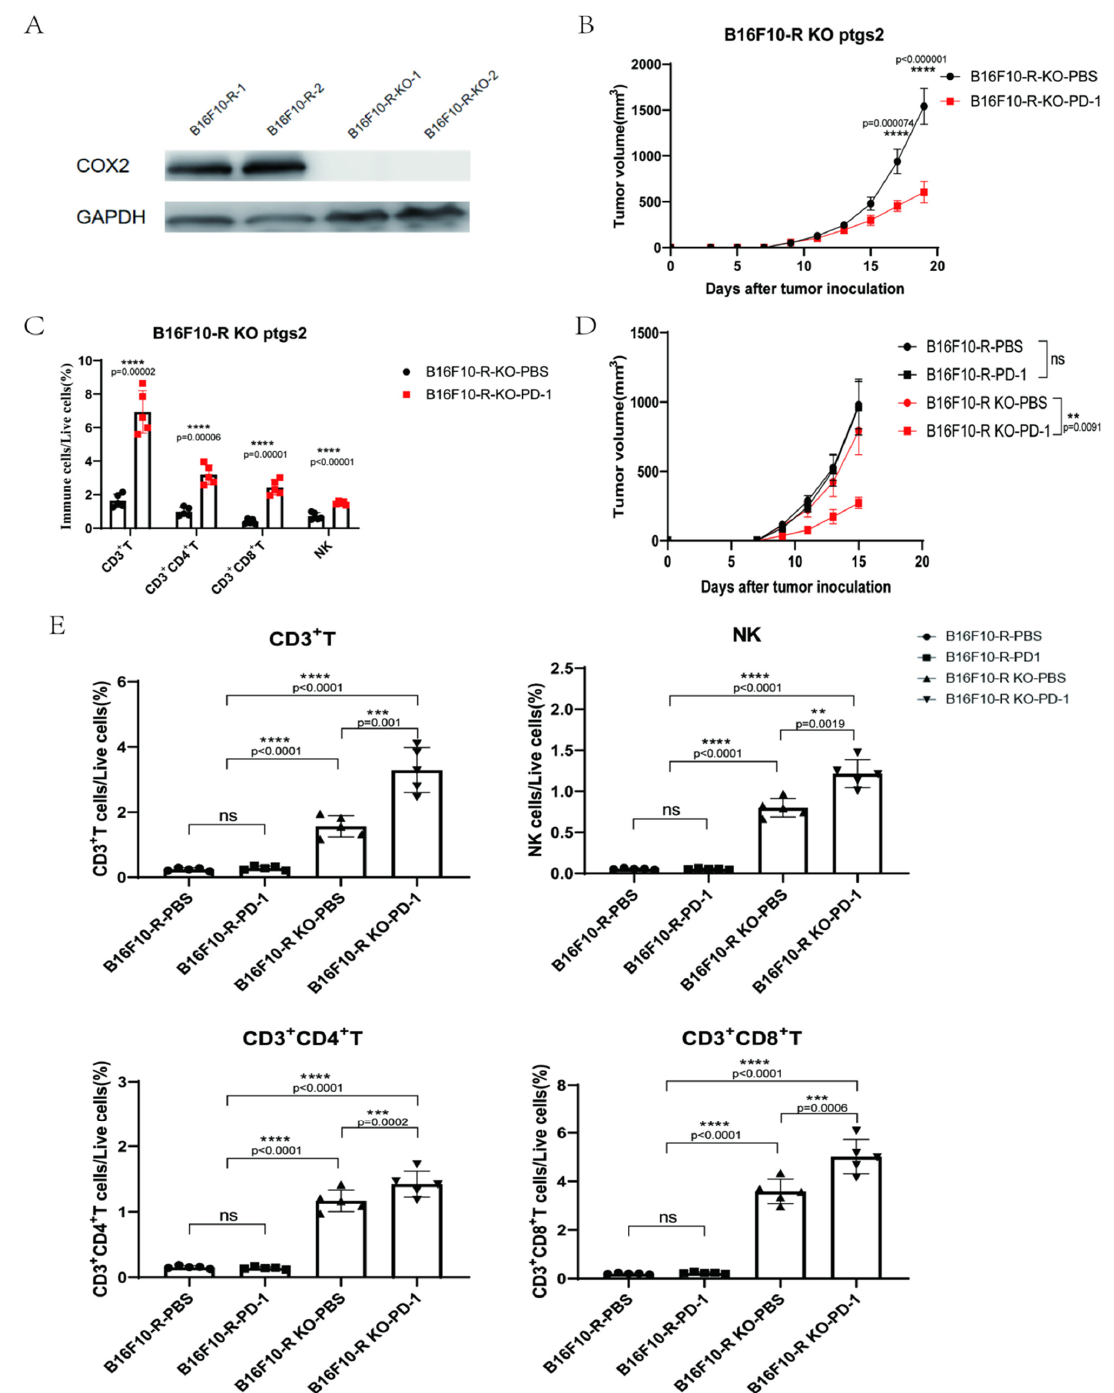
Figure 5. COX2 knockout in B16F10-R cells abrogates acquired resistance to anti-PD-1 therapy. ( A ) Western blot analysis for COX2 expression. GAPDH was the control in the two cell lines. ( B ) Tumour growth curves of B16F10-R-knockout tumours in vivo treated with pembrolizumab or PBS ( n = 6–8/group, two-way ANOVA test, Tukey). ( C ) Differences in the number of infiltrating lymphocytes in B16F10-R-knockout tumours (one-way ANOVA test, Tukey). ( D ) Tumour growth curves of B16F10-R and B16F10-R-knockout tumours in vivo treated with pembrolizumab or PBS ( n = 6–8/group, two-way ANOVA test, Tukey). ( E ) Differences in the number of infiltrating lympho- cytes in B16F10-R-knockout tumours (one-way ANOVA test, Tukey); ns, not statistically significant; ** p < 0.01; *** p < 0.001; **** p <